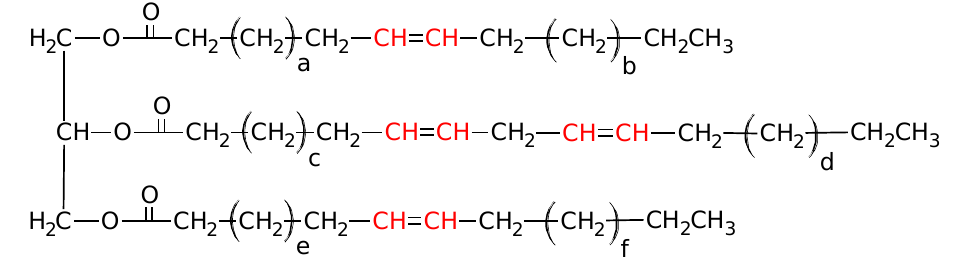
Figure 12. The general structure of the triglyceride.